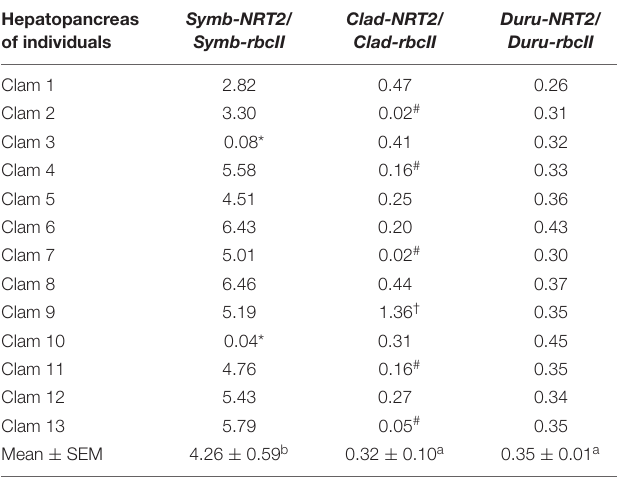
TABLE 7 | Ratios of the transcript levels of nitrate transporter 2 ( NRT2 ) to that of form II ribulose-1,5-bisphosphate carboxylase/oxygenase (rbcII) from Symbiodinium (Symb-NRT2/Symb-rbcII), Cladocopium (Clad-NRT2/Clad-rbcII), and Durusdinium (Duru-NRT2/Duru-rbcII) obtained from the hepatopancreas of Tridacna squamosa ( n =